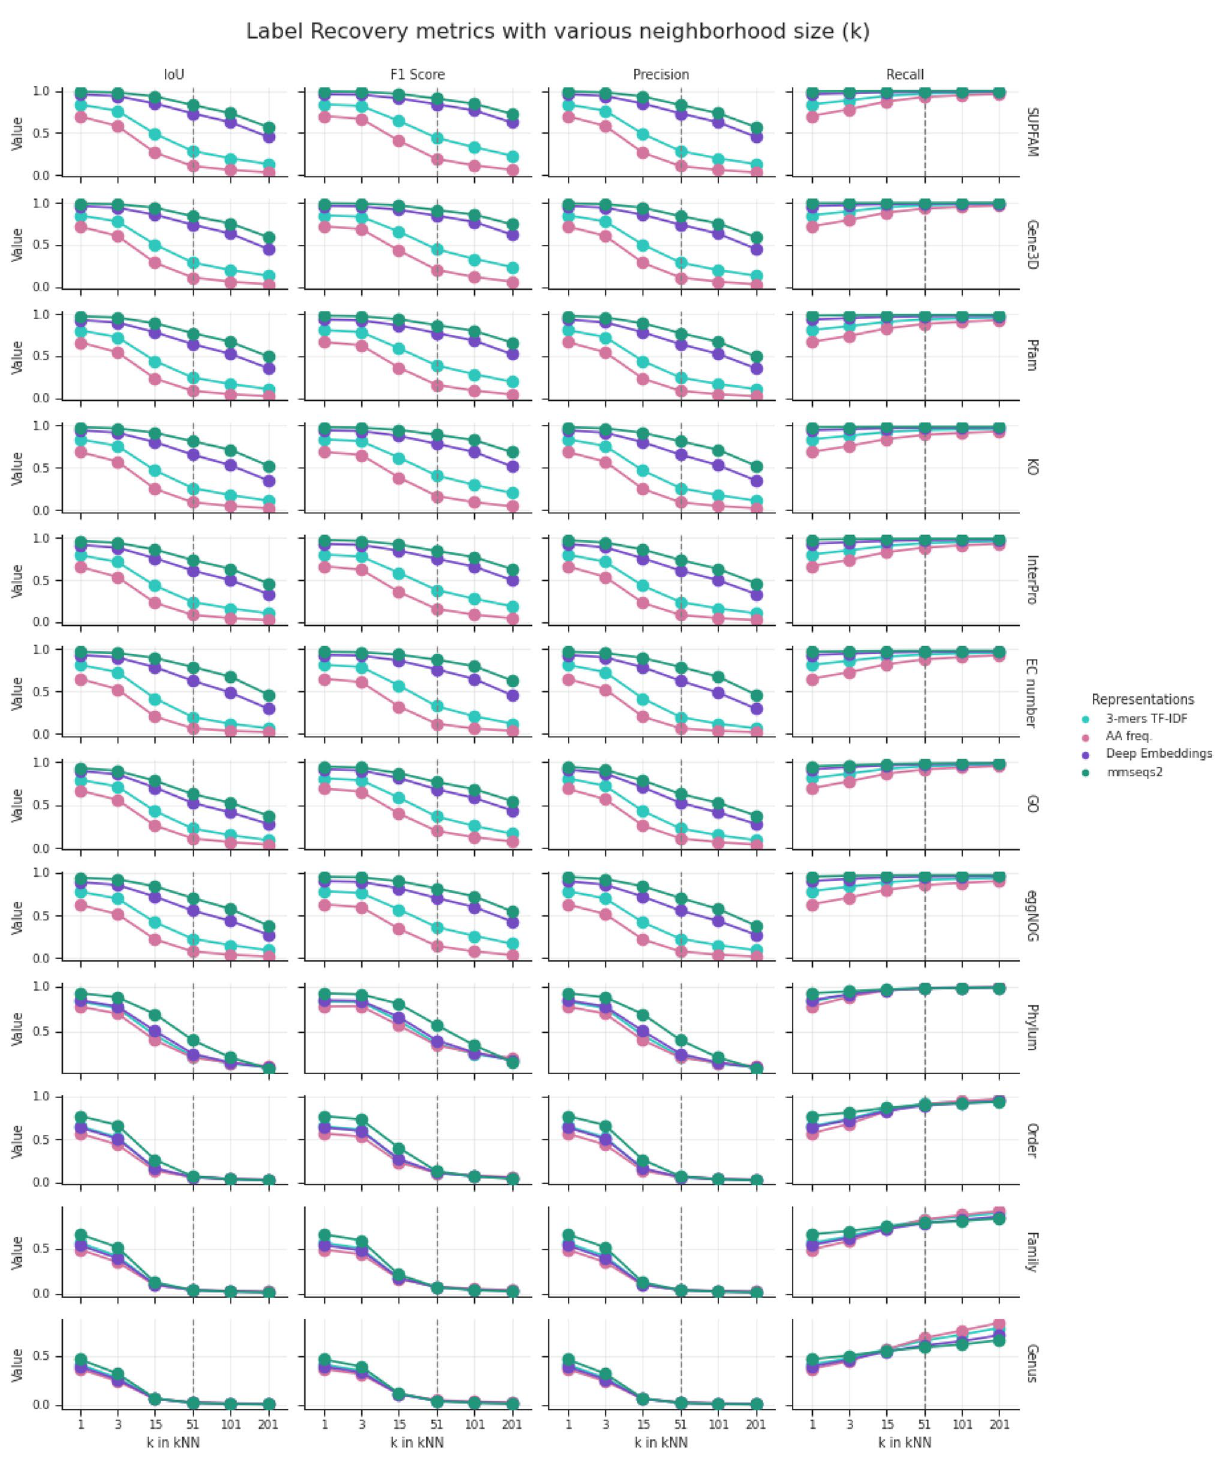
Figure 2. The degree of correctness in the recovery of labels using deep, k-mer-based, and amino acid frequency representations, and MMseqs2—state-of-the-art proteins search tool. The recovery is measured by four metrics: Intersection over Union (IoU), F1 Score, Precision, and Recall. Ontologies are sorted by average